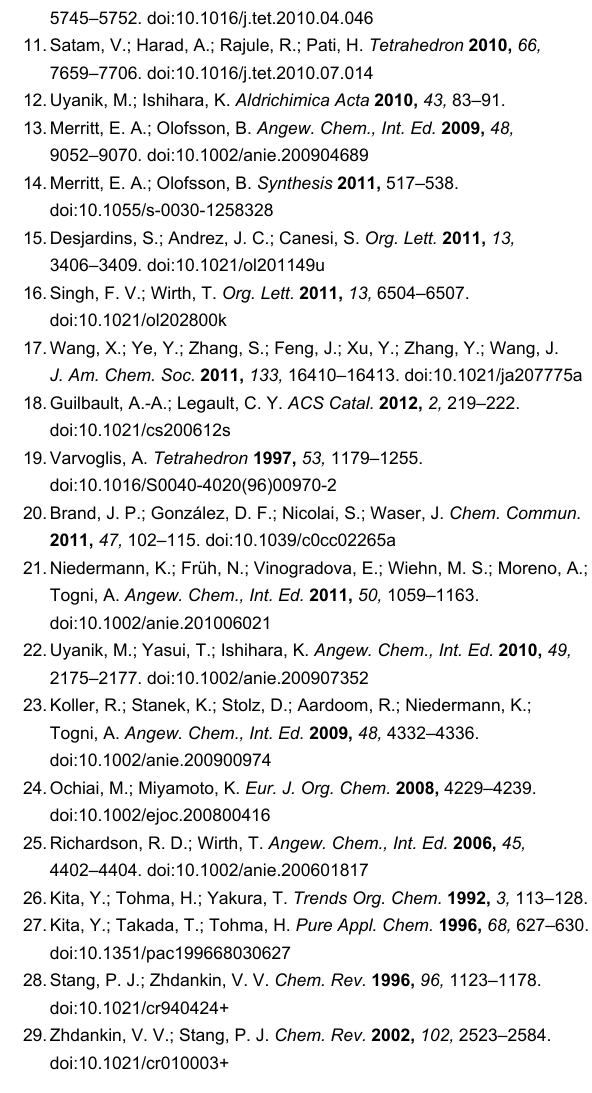
cleavage of a carbon–carbon bond, which significantly expands the value of DIB as a unique and powerful tool in chemical syn- thesis. Future studies on the application of this protocol to the synthesis of other difunctionalized acetamides and detailed investigations of the reaction mechanism are in